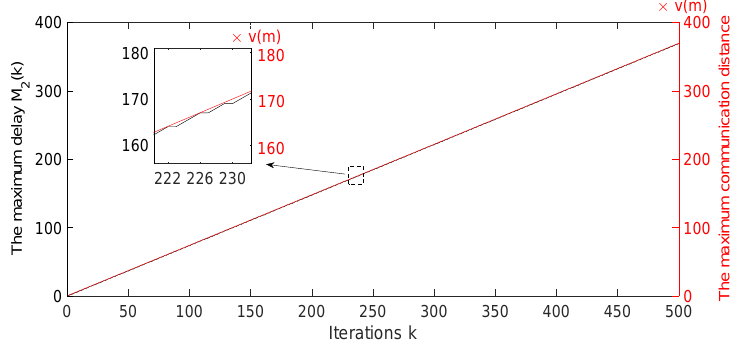
Figure 4. The maximum communication distances C M 2 ( k ) in the simulation (2).